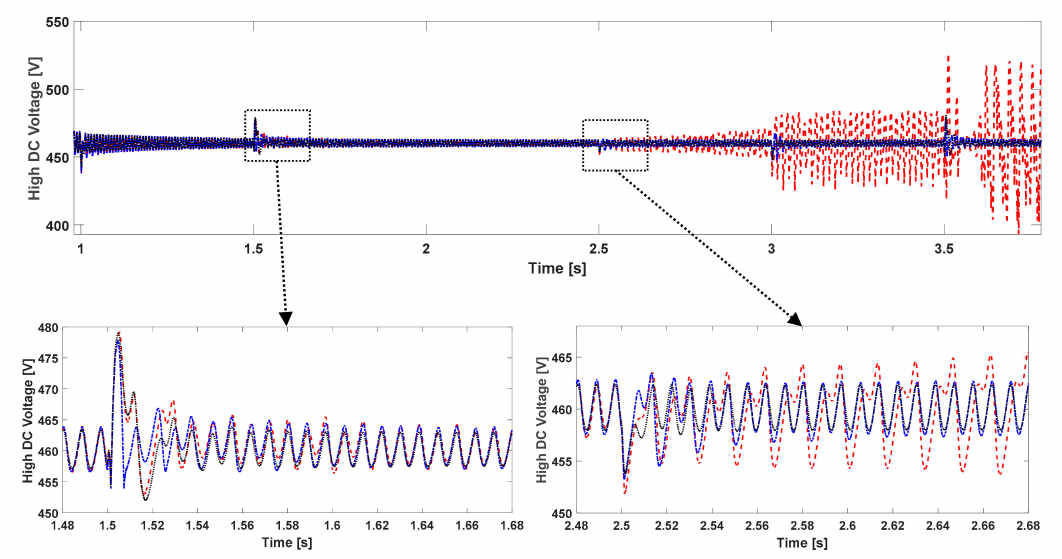
Figure 19. High-DC voltage during faulty operation (65% power-loss